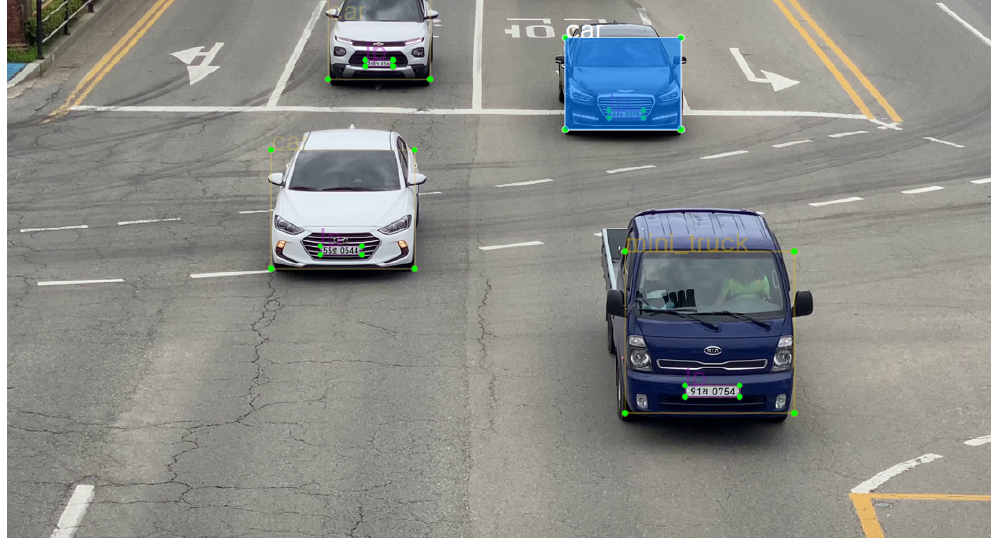
Figure 5. Labeling of vehicle types and license plates to be used for phase